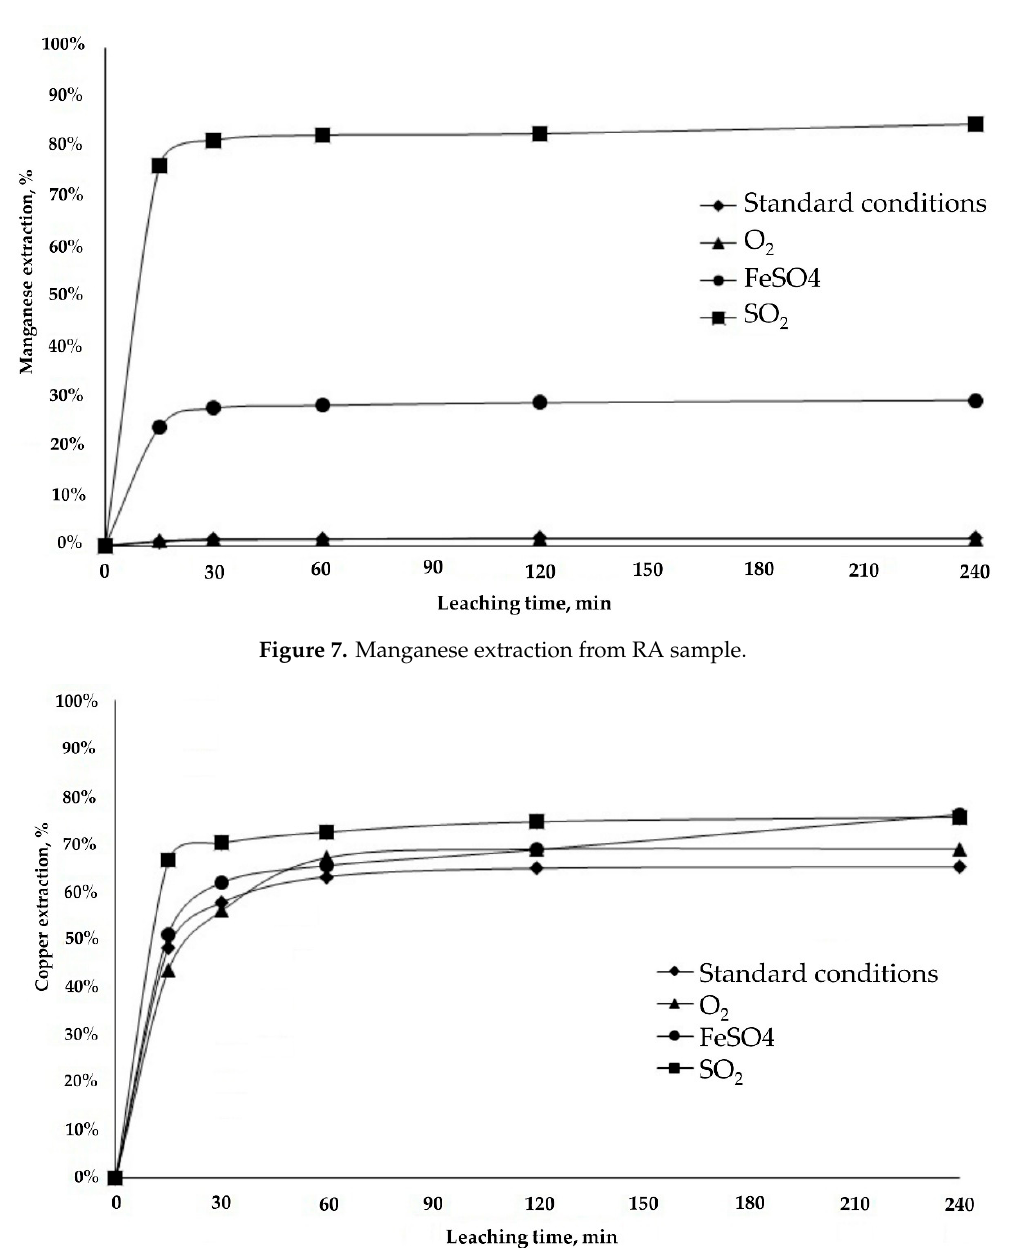
Figure 8. Copper extraction from LB sample.